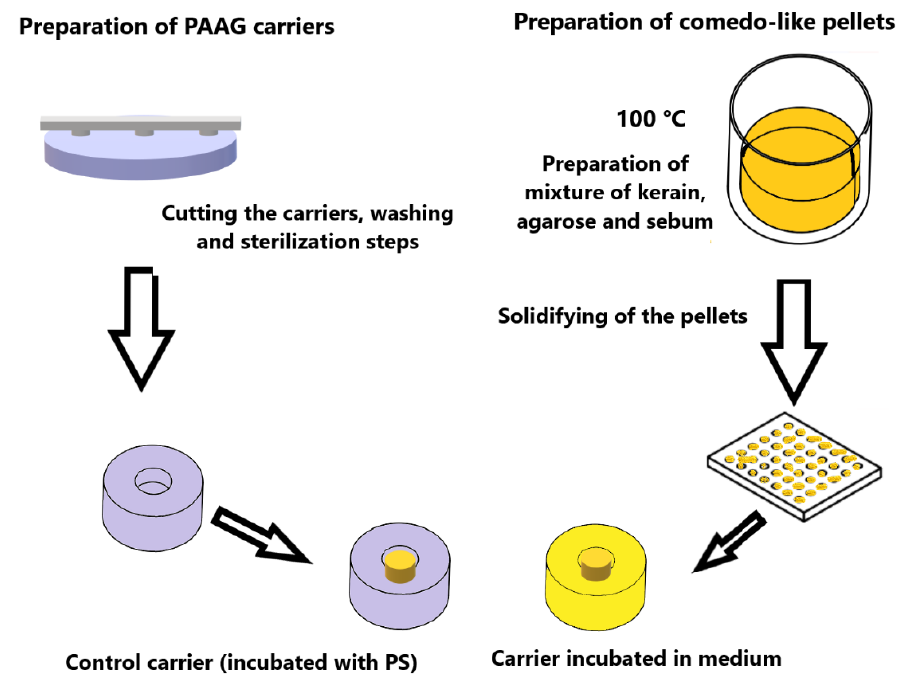
Figure 1. Schematic representation of experimental procedure.